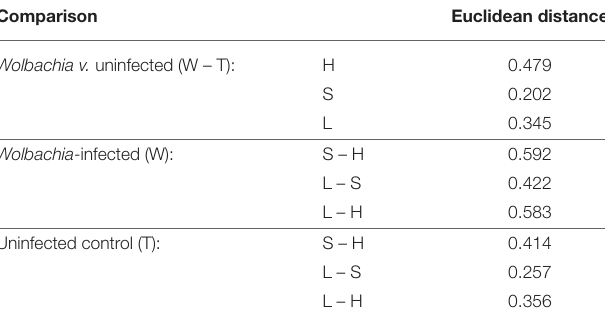
TABLE 2 | Euclidean distances between sample groups in model M1.